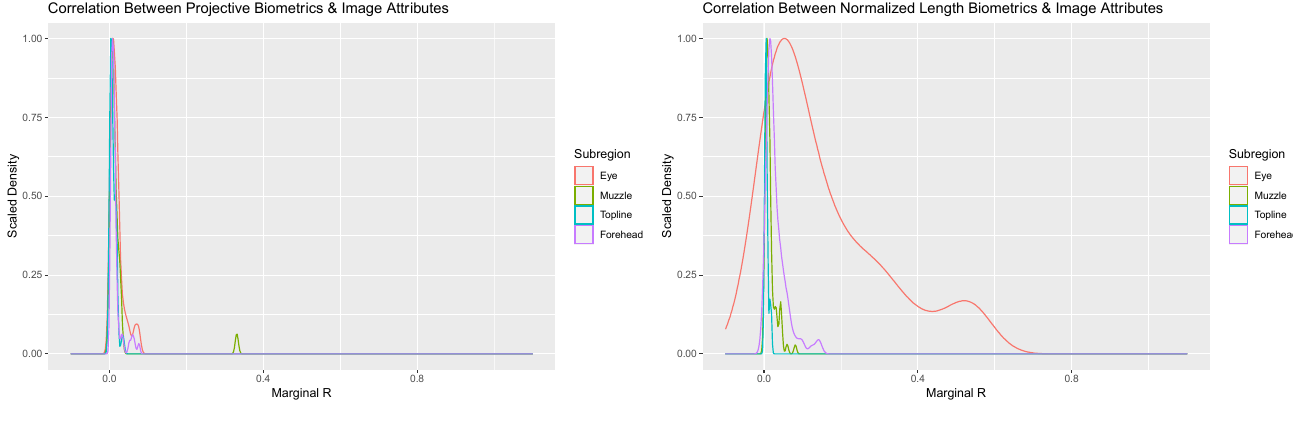
Figure 4. Scaled density plots representing the proportion of variability in normalized length ( right ) and projective biometrics ( left ) additively associated with Frame:Face Ratio and Face Angle for the four anatomical subregions of the face